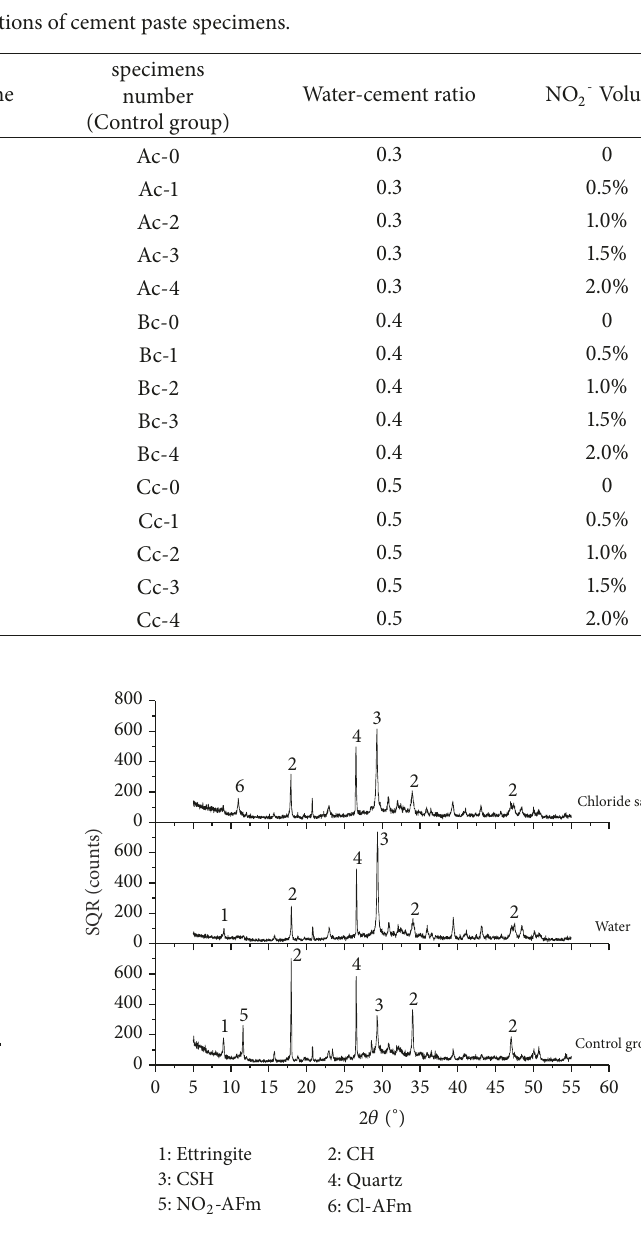
Figure 2: XRD of cement paste with 1.0% NO 2 -